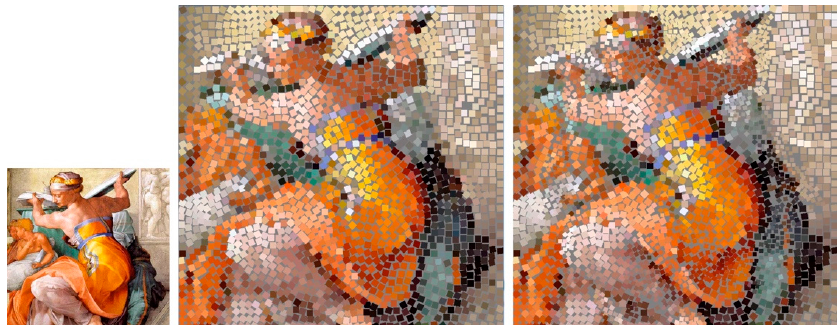
Figure 19. Synthesis results without (middle) and with (right) size variation of the elements (the size variation of the right image is controlled by the density graph extracted from the left image).